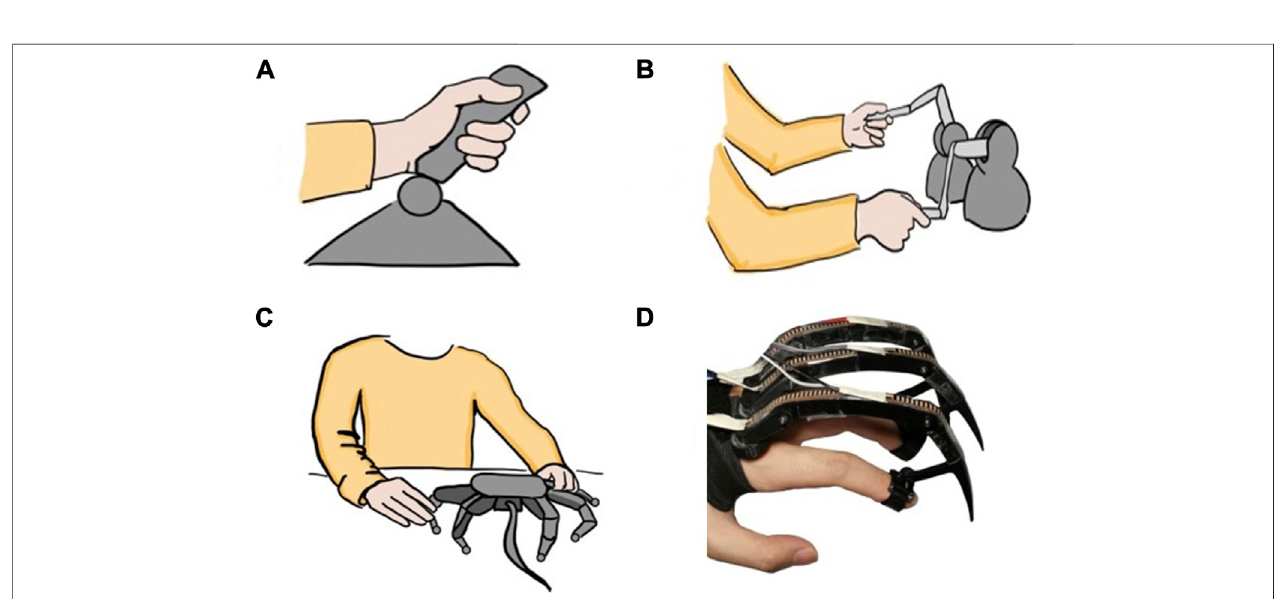
FIGURE2| Differentcontrolinterfacesforhexapodlocomotioncontrol (A) Ajoystickcontrolinterface(Kurisu,2011)iseasytouseforindicatinggeneraldirectionof walking, but would be frustrating if trying to have robot step in particular spots (B) Haptic device interfaces (Huang et al., 2021) provide helpful feedback to the user, but requirelargearmmovementsofbotharms (C) Ascaledmodel(Maeetal.,2017)enablesdetailedcontrolofeachjointbutwouldbeslowandtiringtomoveeachjoint (D) Our proposed HHCI enables precise placement of feet with small fi nger motions on one hand.